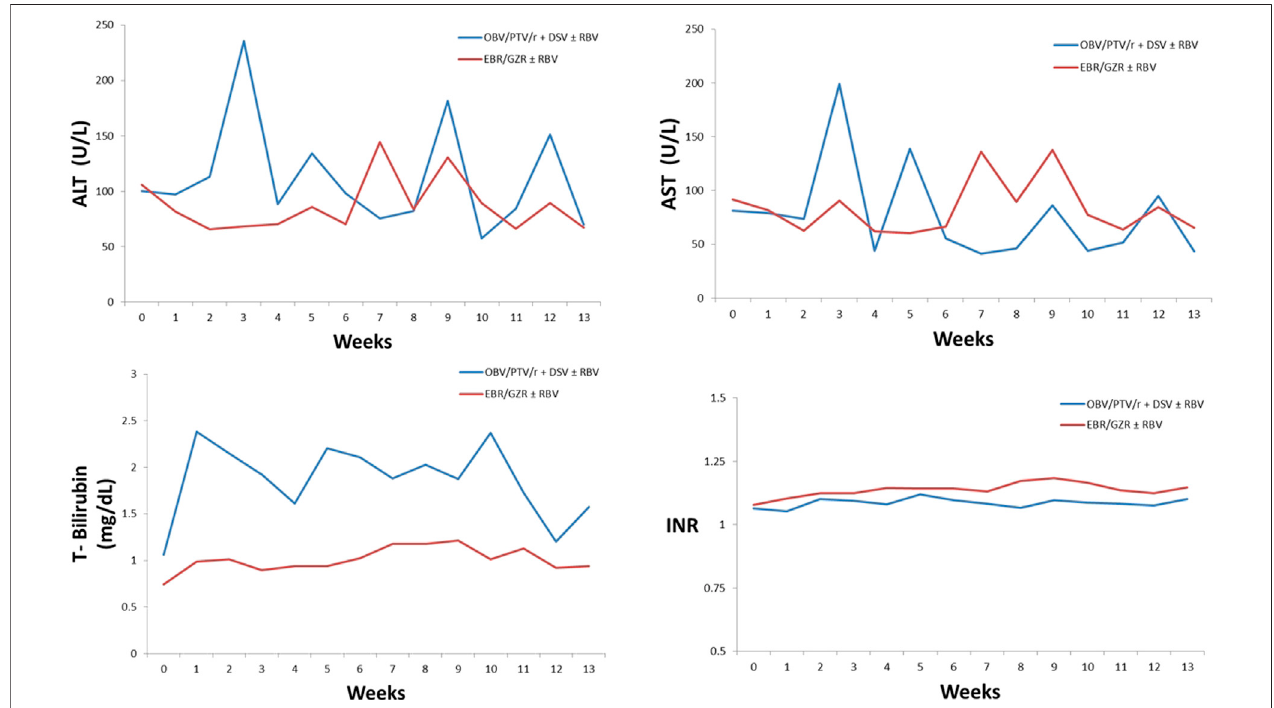
FIGURE 4 | Laboratory parameters among patients with DILI adverse events.